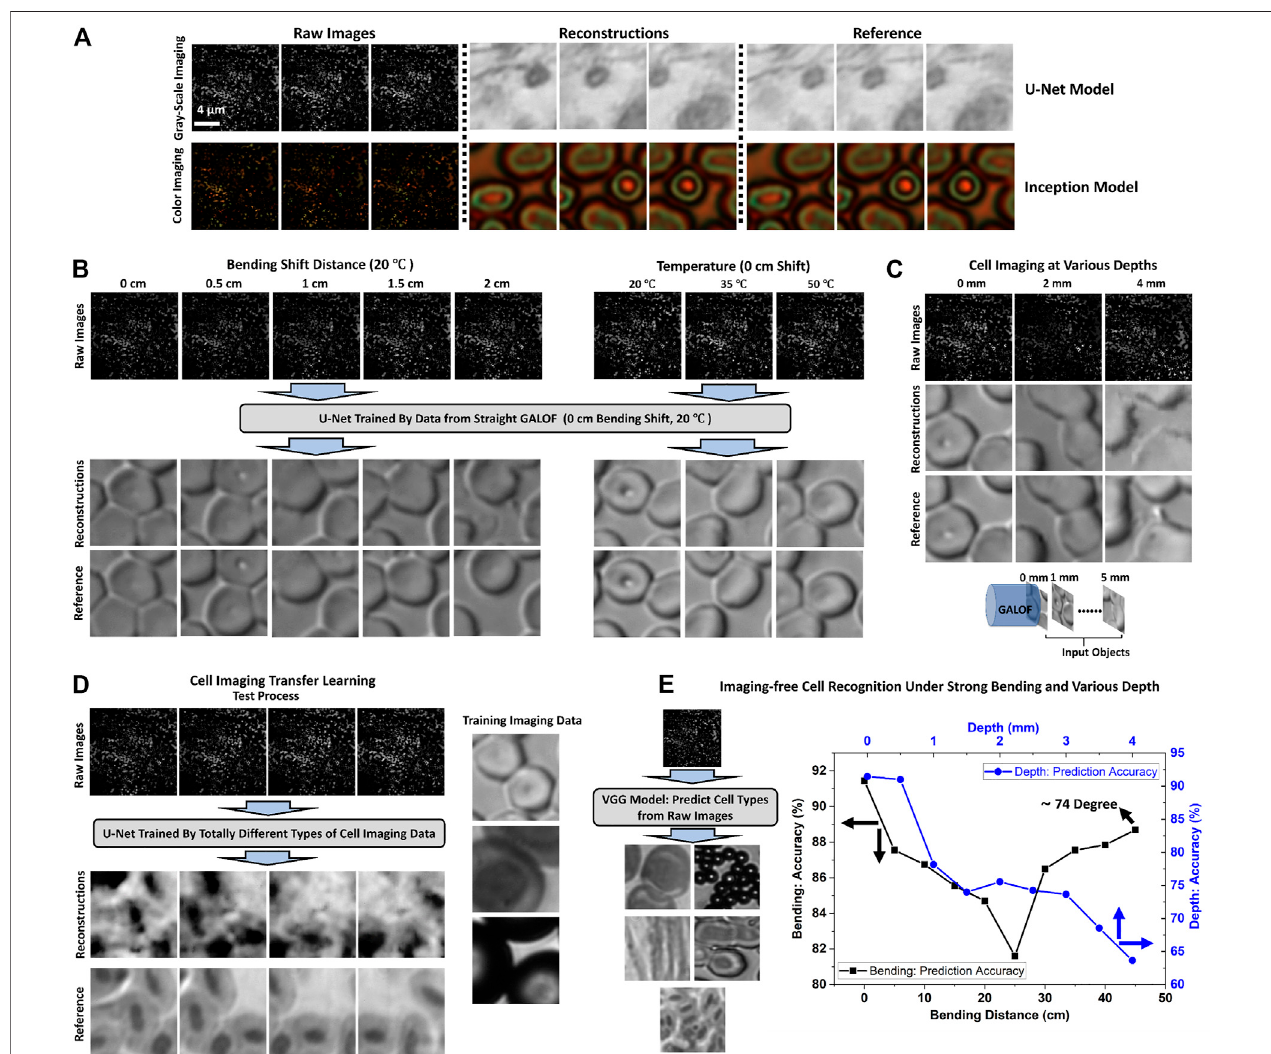
FIGURE 8 | (A – D) Cell image reconstruction results based on GALOF-DCNN systems. (A) Top row: gray-scale cell imaging for cancerous human stomach cells. Images in the top row are adapted with permission from [19]. Bottom row: color cell imaging for human red blood cells. Images in the bottom rows are adapted with permission from [134] © The Optical Society. Both gray-scale and color images are obtained under 0 mm object depth, (B) Cell imaging robustness tests under both mechanicalbendingandthermalvariationsat0 mmobjectdepth, (C) Cellimagetransportundervariousobjectdepthsforstraight fi berstatus. (A – C) TheDCNNis trained and tested using the same type of cell breed. More details refer to [19], (D) Transfer learning test for cell image transport under straight fi ber status and 0 mm object depth. The DCNN model is trained (human red blood cells, frog blood cells and polymer microspheres) and tested (bird blood cells) using different types of cell breeds.Moredetailsreferto[19].Imagesin (B – D) areadaptedwithpermissionfrom[19], (E) Cellrecognitiontestresultsunderdifferentbending(0 mmobjectdepth)and object depth (straight fi ber) status. The images are adapted with permission from [52]. More details refer to [52] ©